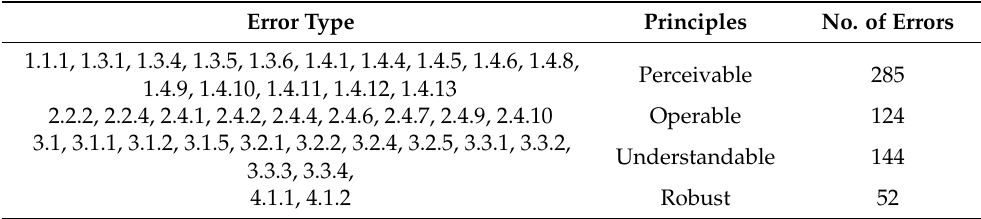
Table 15. Frequently appeared errors with their associated